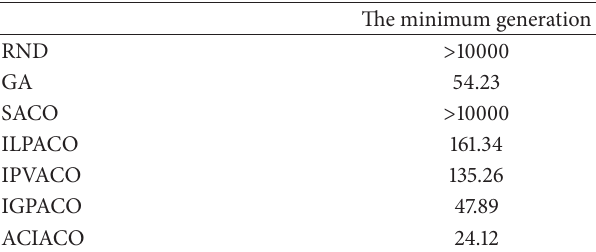
Table 4: The average minimum